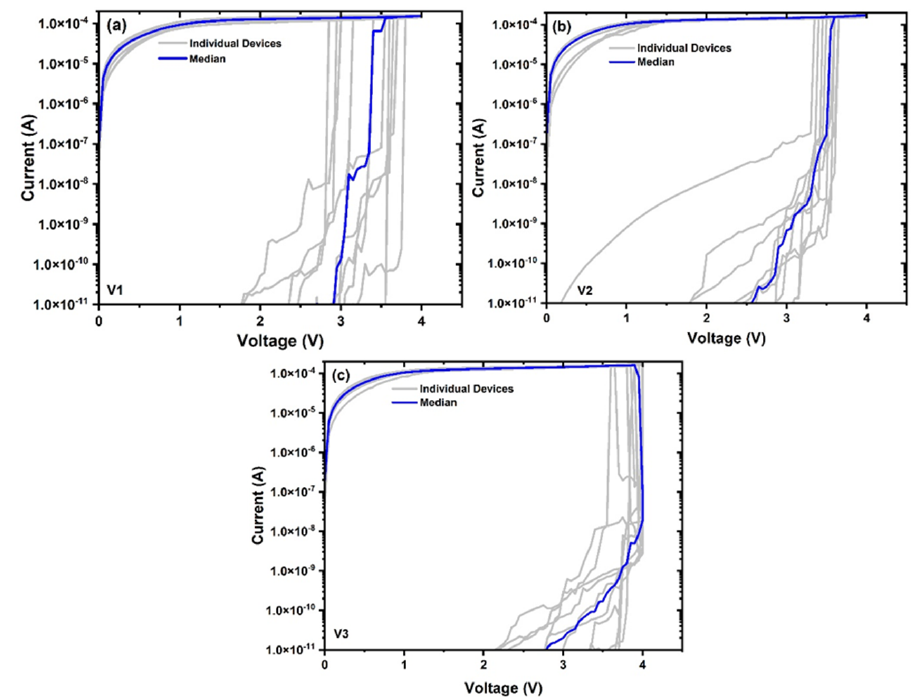
Figure 5. Forming I–V characteristics of ( a ) V1, ( b ) V2 and ( c ) V3 device variants. The characteristics of individual devices from each variant are represented in grey, and the computed median curves are represented in blue.